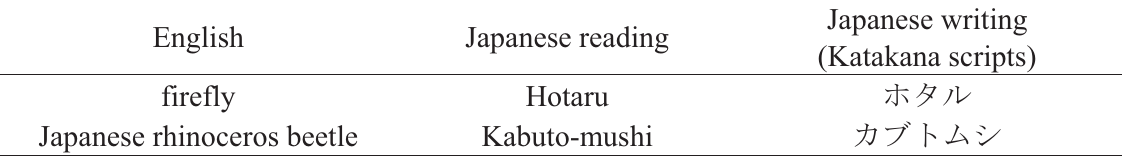
Table 1. Japanese transcription (Katakana) of the firefly (Lampyridae) and Japanese rhinoceros beetle ( Allomyrina dichotoma